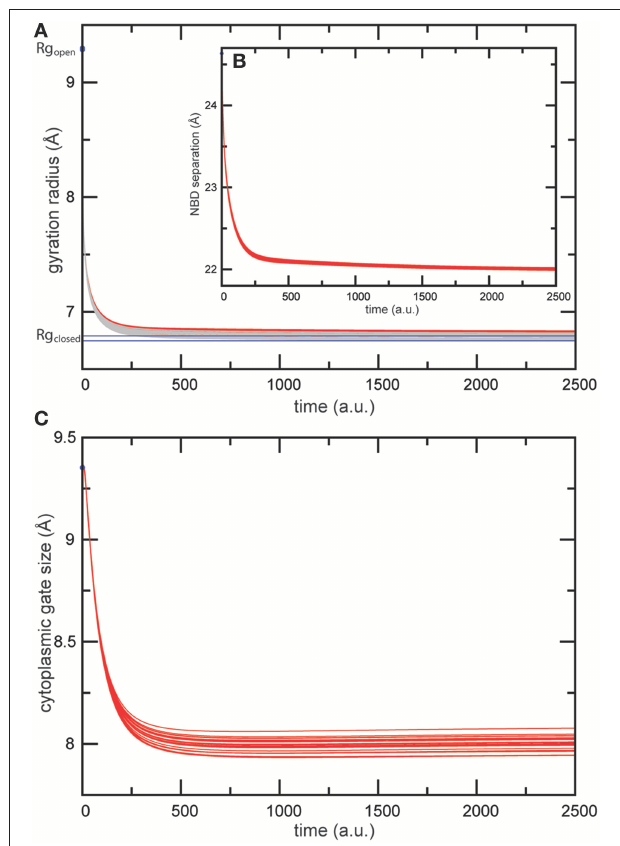
FIGURE 5 | Trajectories of conformational changes in the maltose transporter. Trajectories characterizing conformational motions along the formation of the ligand-bound MalFGK 2 structures are shown for 20 different ligand-binding realizations. (A) Changes in the gyration radius of each nucleotide-binding pocket are shown as red and gray curves. Values of pocket radii computed for the AMP-PNP-bound crystal structure are indicated as blue lines. (B) Trajectories monitoring the separation of the two NBDs as it changed during the simulations. (C) Trajectories monitoring shrinking in the size of the cytoplasmic